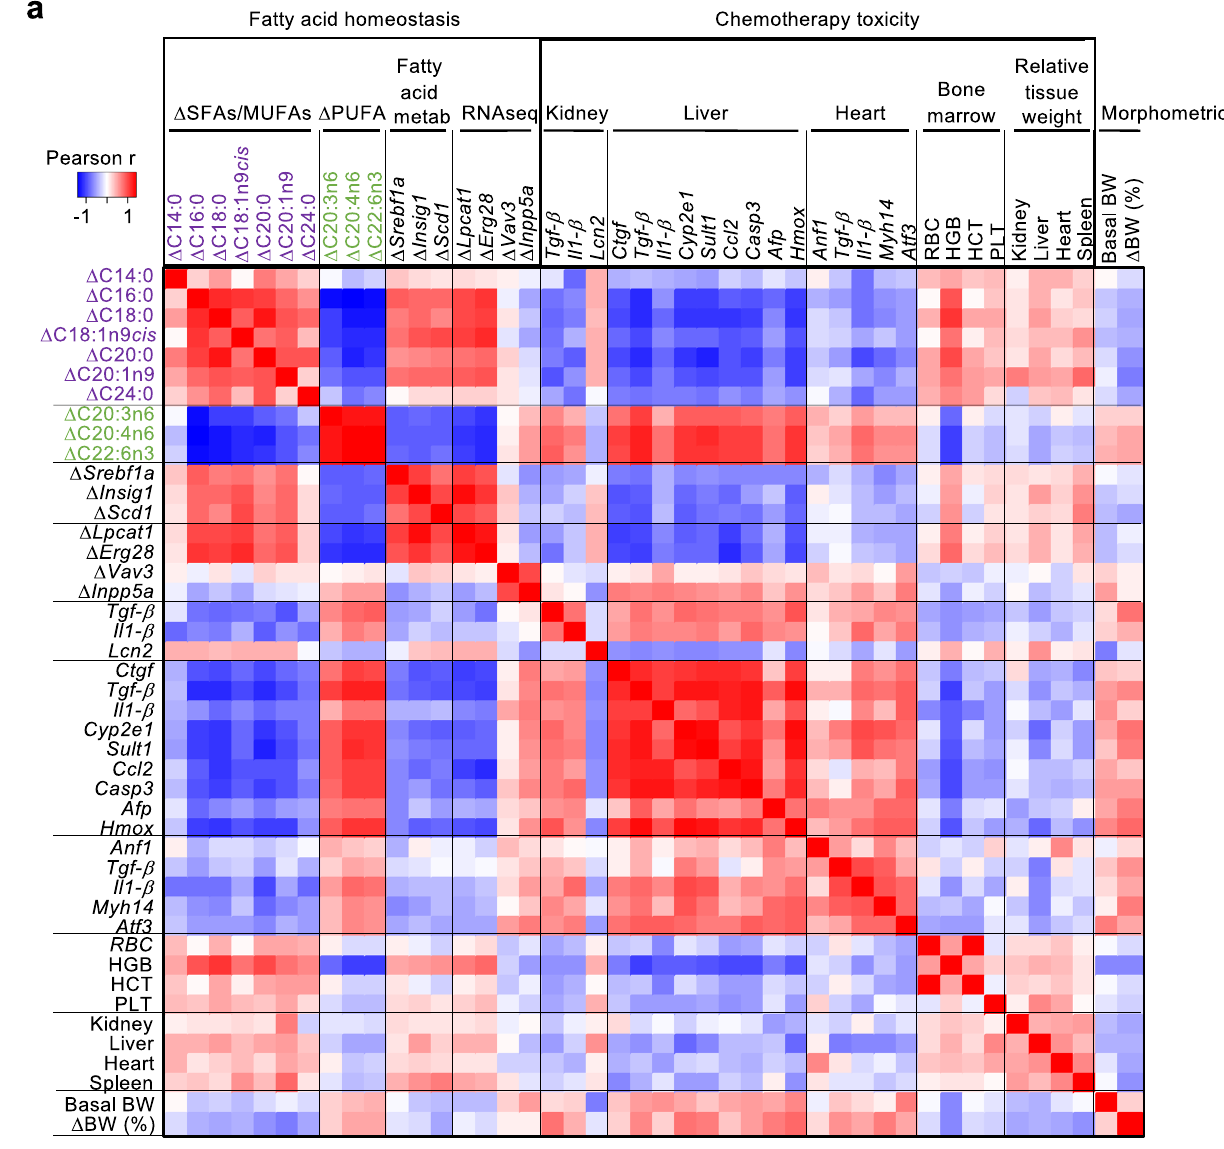
Fig. 6 | Correlation of fatty acid homeostasis biomarkers with chemotherapy toxicity in mice. a Heatmap depicting the Pearson correlation r coef fi cients between the indicated fatty acid homeostasis biomarkers (membrane fatty acids, Srebf1 pathway genes in PBMCs and RNAseq-identi fi ed genes) with chemotherapy toxicity biomarkers: expression of toxicity-responding genes in kidney, liver and heart; bone marrow-associated parameters red blood cell counts (RBC),